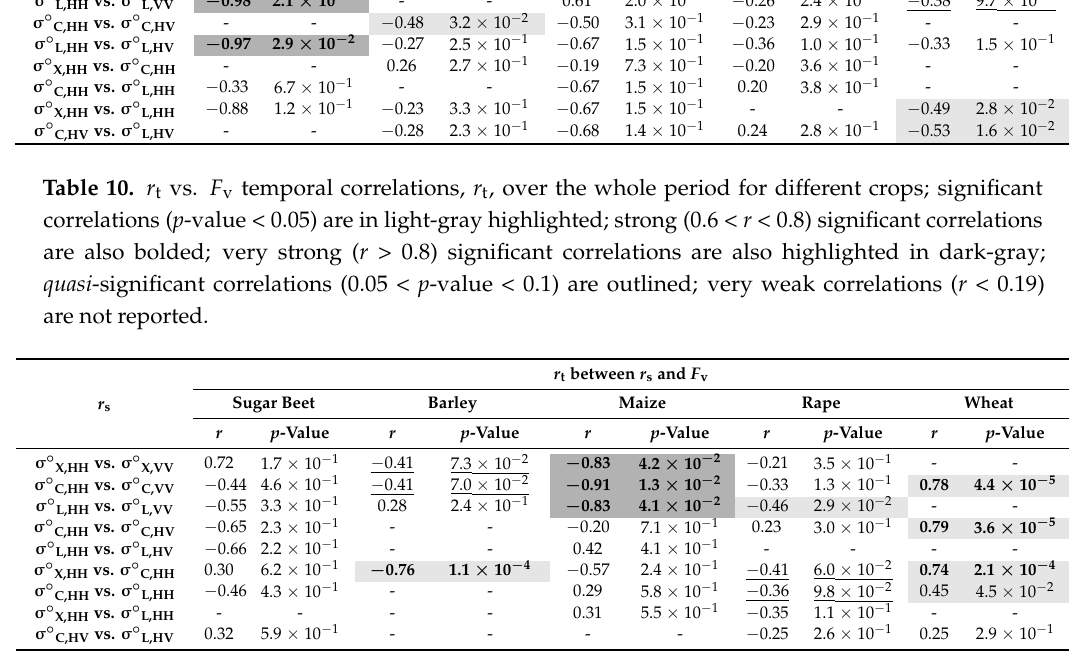
Table 11. r t vs. LAI temporal correlations, r t , over the whole period for different crops; significant correlations ( p -value < 0.05) are in light-gray highlighted; strong (0.6 < r < 0.8) significant correlations are also bolded; quasi -significant correlations (0.05 < p -value < 0.1) are outlined; very weak correlations ( r < 0.19) are not